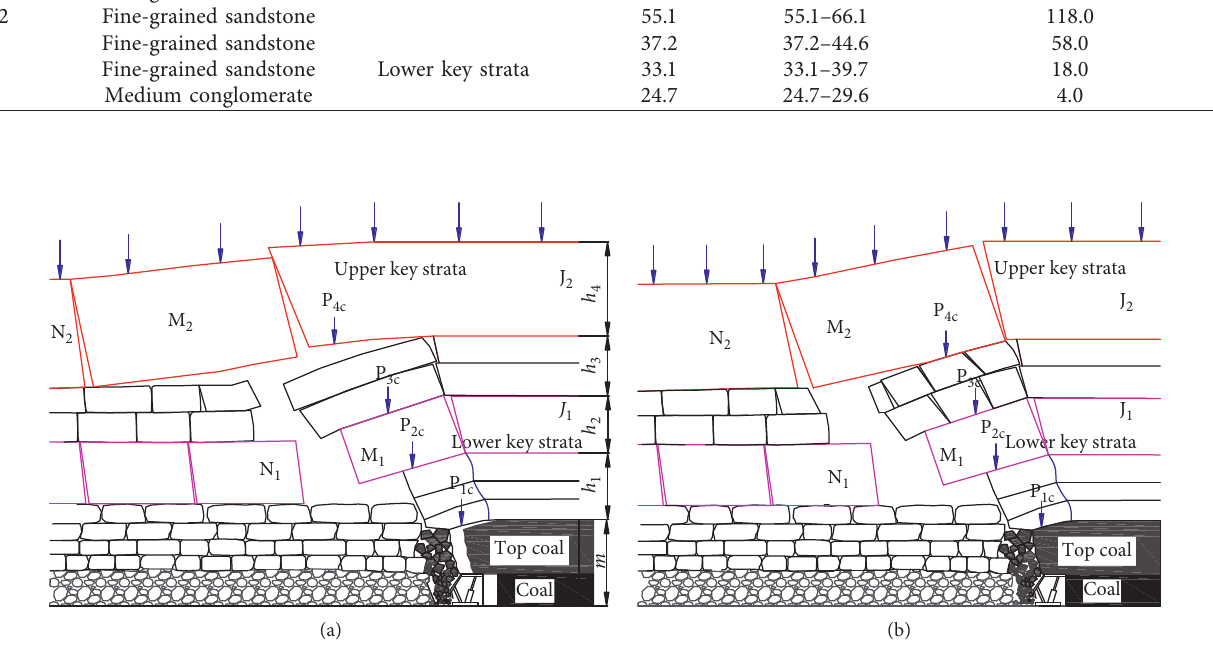
Figure 7: Composite structures of lower cantilever beam and upper voussoir beam with hard main roof. (a) Instability of lower cantilever beam. (b) Synchronous instability of lower and upper